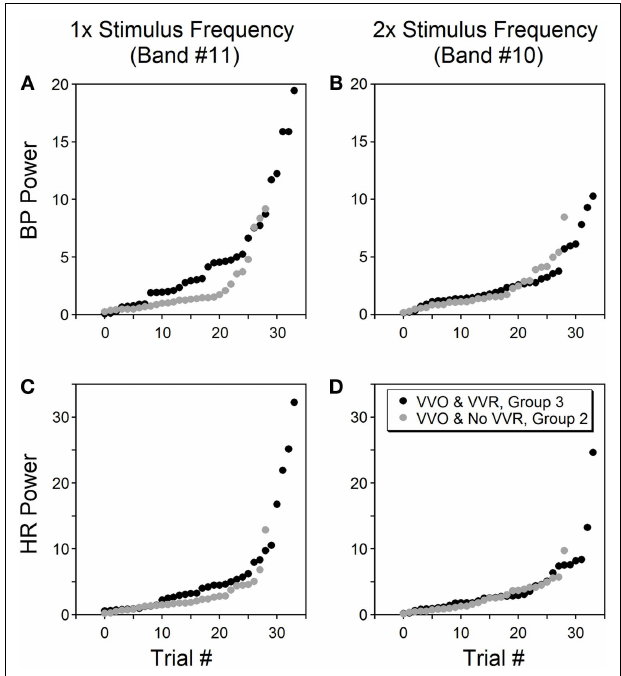
FIGURE 8 | Power of BP (A,B) and HR (C,D) at bands containing the stimulus frequency (left column) and twice the stimulus frequency (right column) . Data were from six rats tested by sGVS at 0.025Hz. Only trials that induced vasovagal oscillations (VVO) are shown, from which 34 trials (black circles, group 3) also induced vasovagal responses (VVR).The other 29 trials (gray circles, group 2) had vasovagal oscillations but no vasovagal responses.The abscissa (trial #) represents the order of each trial, is sorted on the magnitude of its power within a specific frequency band. The power in the stimulus frequency band was generally greater when there were vasovagal responses, more so for BP than for HR. However, the power was essentially the same in the double stimulus frequency band regardless of whether there were vasovagal responses or not.